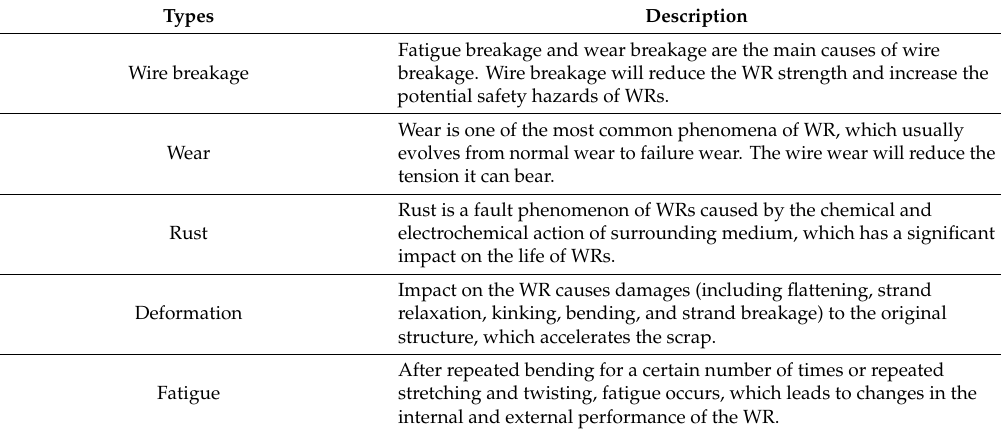
Table 1. Types and description of wire rope (WR)